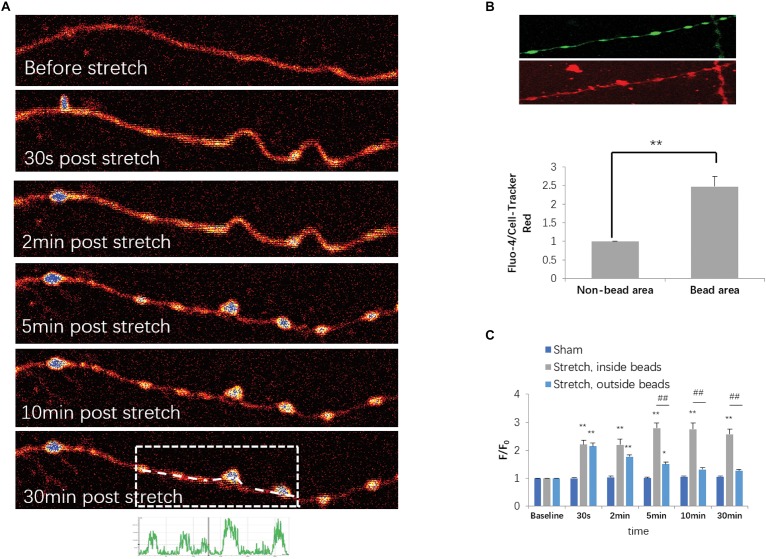
Stretch-triggered [Ca2+]axo dynamic alterations. (A) Representative serial images of fluo-4-loaded axons with pseudocolor at designated time points. (B) Upper panel, fluo-4- and CellTracker Red (CTR)-labeled axons at 30 min after stretch. Lower panel, fluo-4 intensities normalized against CTR intensities for comparison of [Ca2+]axo between the sites within and outside of the spheroids (paired t-test, ∗∗P < 0.01; n = 7). (C) Quantitative analysis for [Ca2+]axo in neurons subjected to either sham operation or stretch for each duration range (all data were presented as mean ± SE; one-way ANOVA, n ≥ 6; ∗∗P < 0.01, comparison between sham groups and stretch inside the spheroids groups; #P < 0.05, ##P < 0.01, comparisons between sham groups and stretch outside of the spheroid groups; &P < 0.05, &&P < 0.01, comparisons between stretch within and out of the spheroid groups).